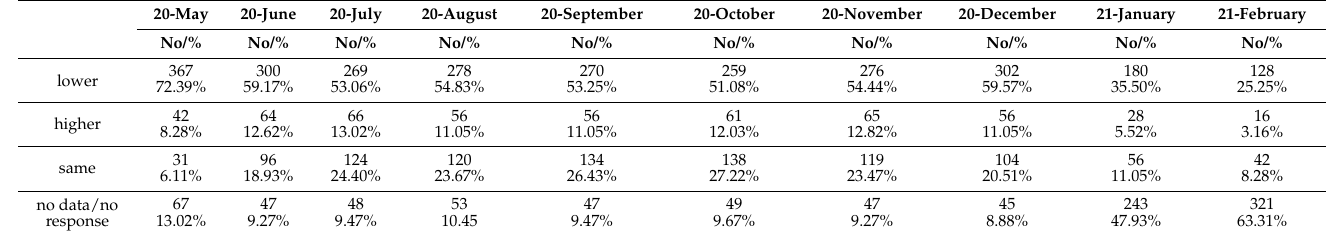
Table 2. Patient volume in 2020 compared to